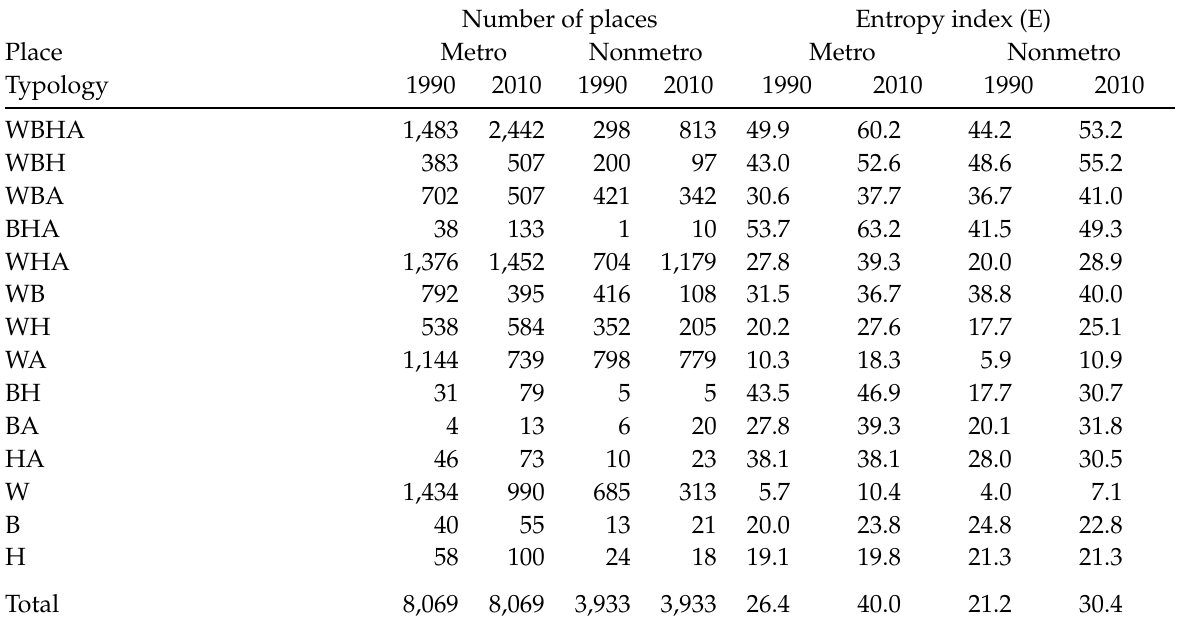
Table 1: Place Characteristics, 1990-2010 Number of places Entropy index (E) Place Metro Nonmetro Metro